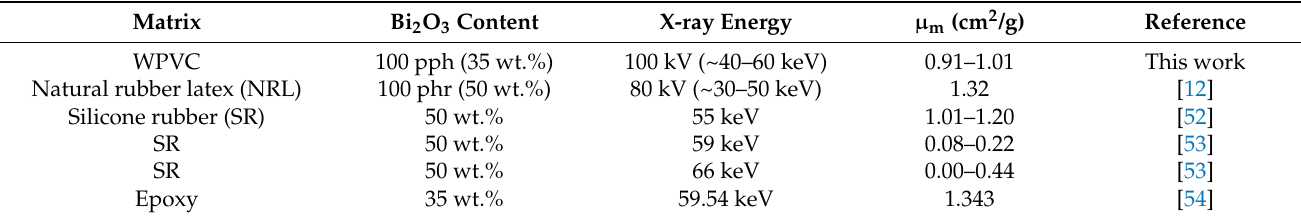
Table 5. Comparative X-ray shielding properties of WPVC and other composites containing Bi 2 O 3 as X-ray protective filler. Matrix Bi 2 O 3 Content X-ray Energy µ m (cm 2 /g) Reference WPVC 100 pph (35 wt.%) 100 kV (~40–60 keV) 0.91–1.01 This work Natural rubber latex (NRL) 100 phr (50 wt.%) Silicone rubber (SR) 50 wt.% SR Epoxy 35